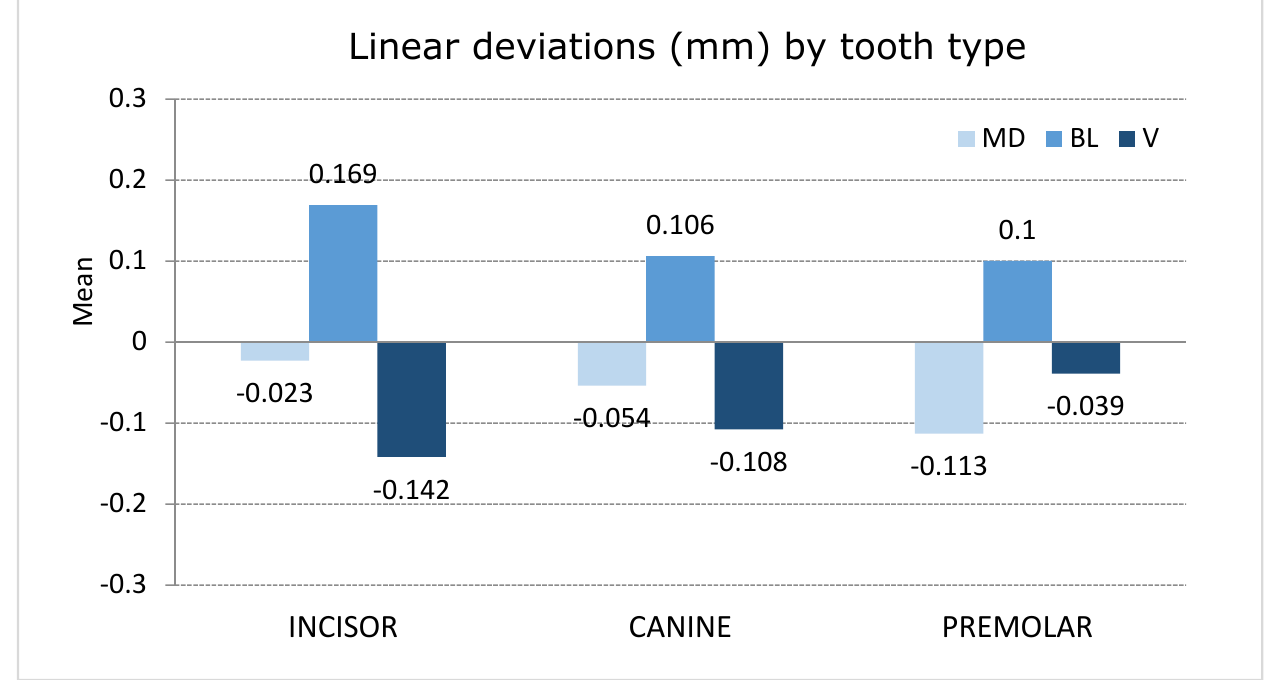
Figure 7. Plot of the mean values of the mesio-distal, bucco-lingual/palatal, and vertical deviations of incisors, canines, and premolars.